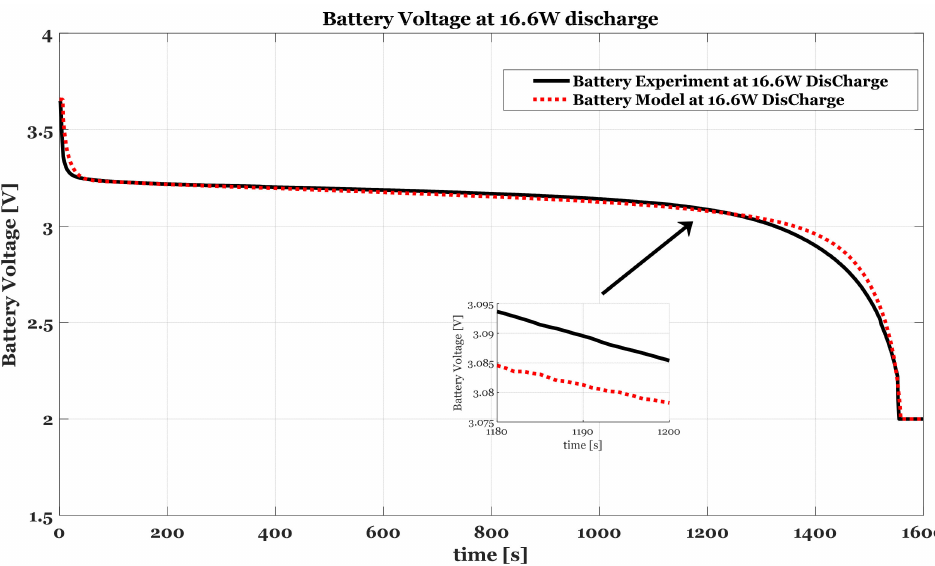
Figure 8. Battery model versus experimental results: Battery discharge voltage at 16.6 W (black– experimental, and